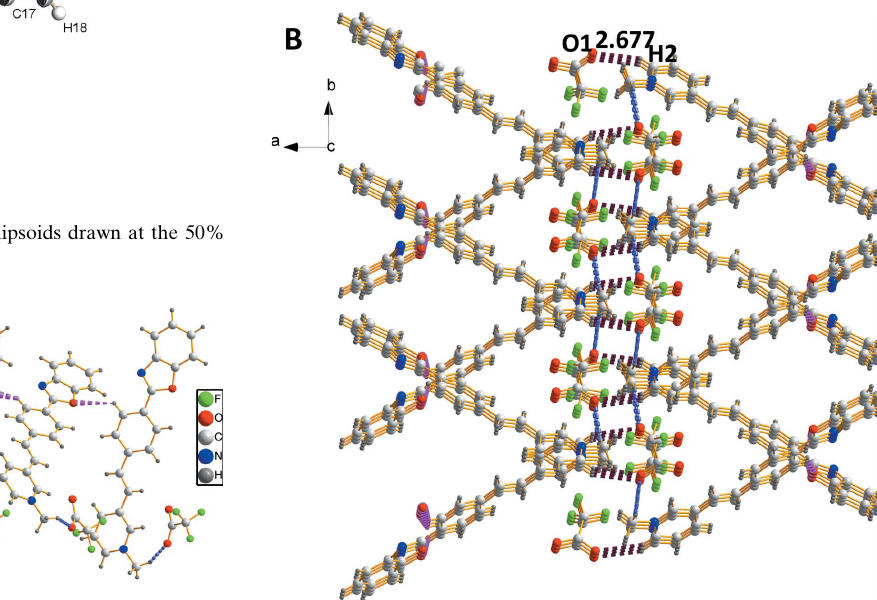
Figure 2 Hydrogen-bonded chain in the crystal.